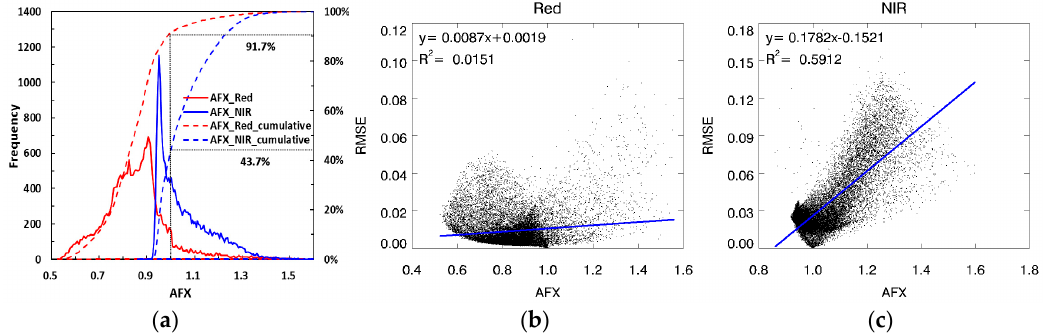
Figure 4. Relationships between fit-RMSE and AFX in the red and NIR bands: ( a ) histogram of AFX; ( b ) relationship for the red band; and ( c ) relationship for the NIR band.